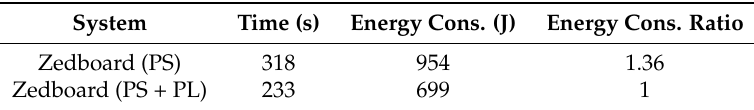
Table 7. Power dissipation of the Zedboard for the Vaihingen